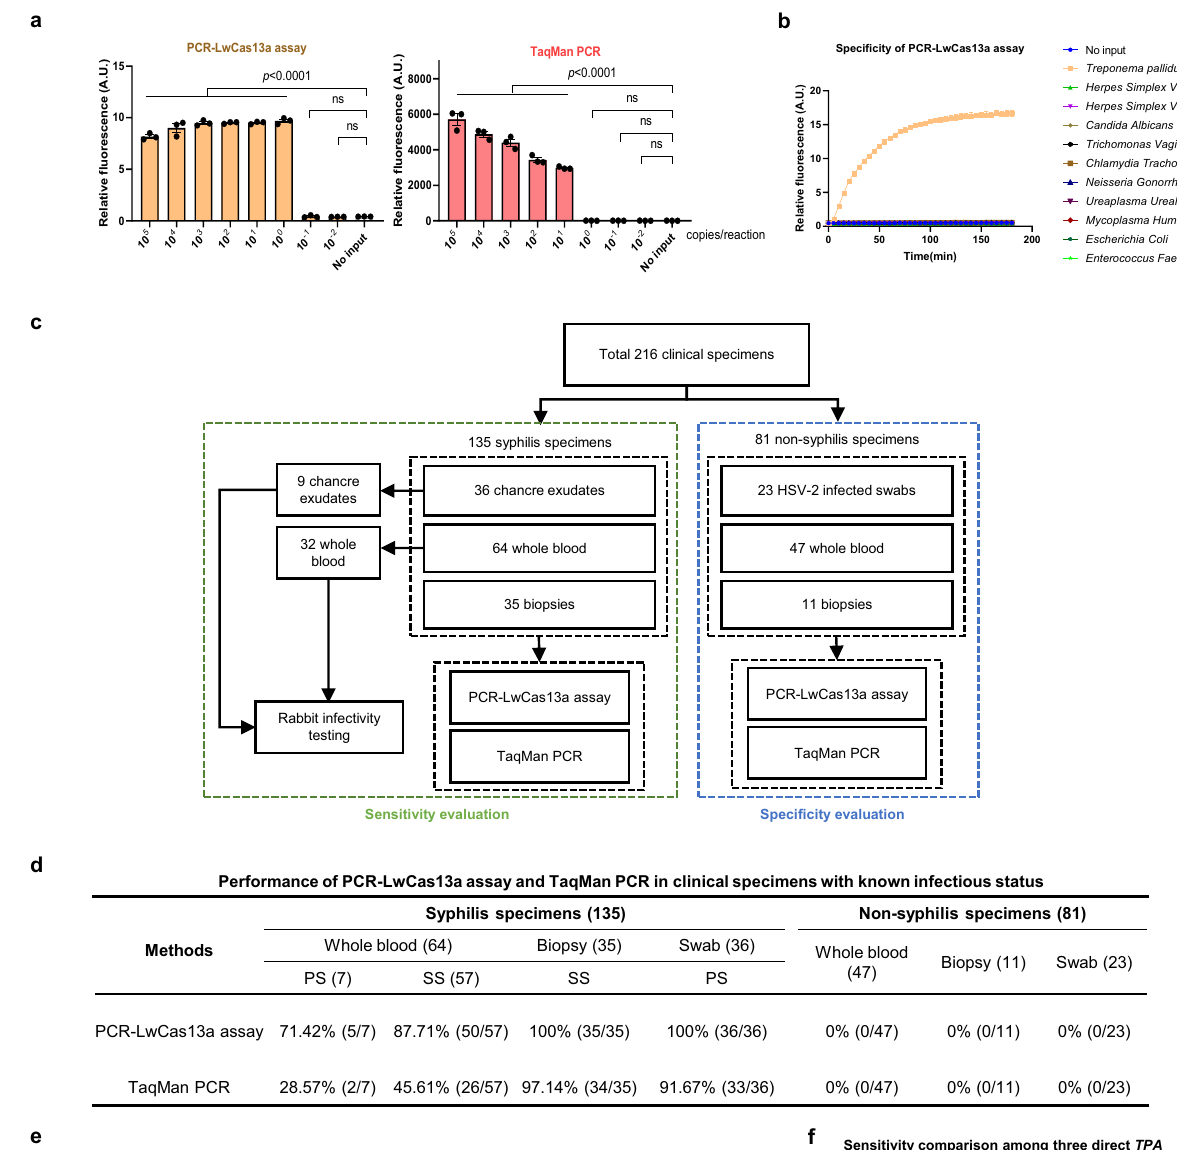
Sensitivity comparison among three direct TPA detection methods in 41 specimens